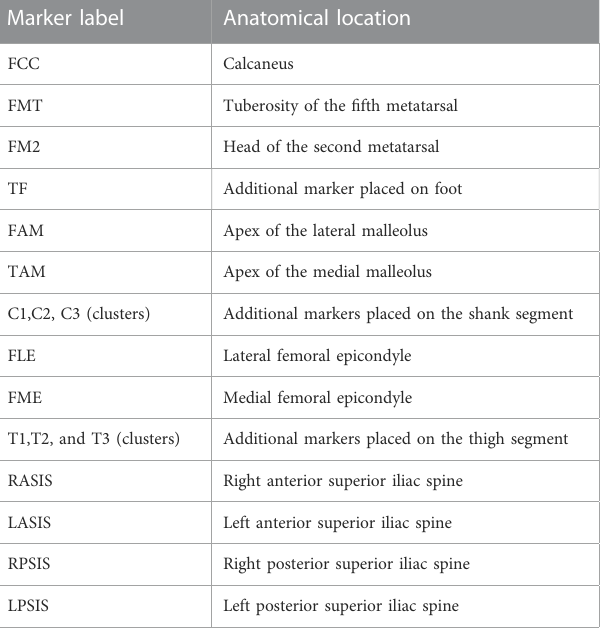
TABLE 2 Optical motion tracking cluster and marker positions and labels. Marker